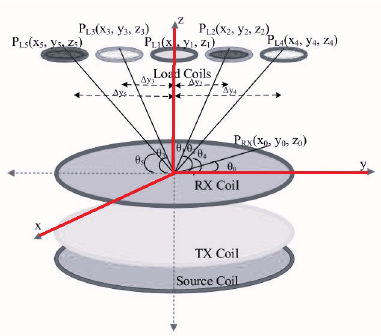
Figure 27. The configuration of the WPT system developed in [59].